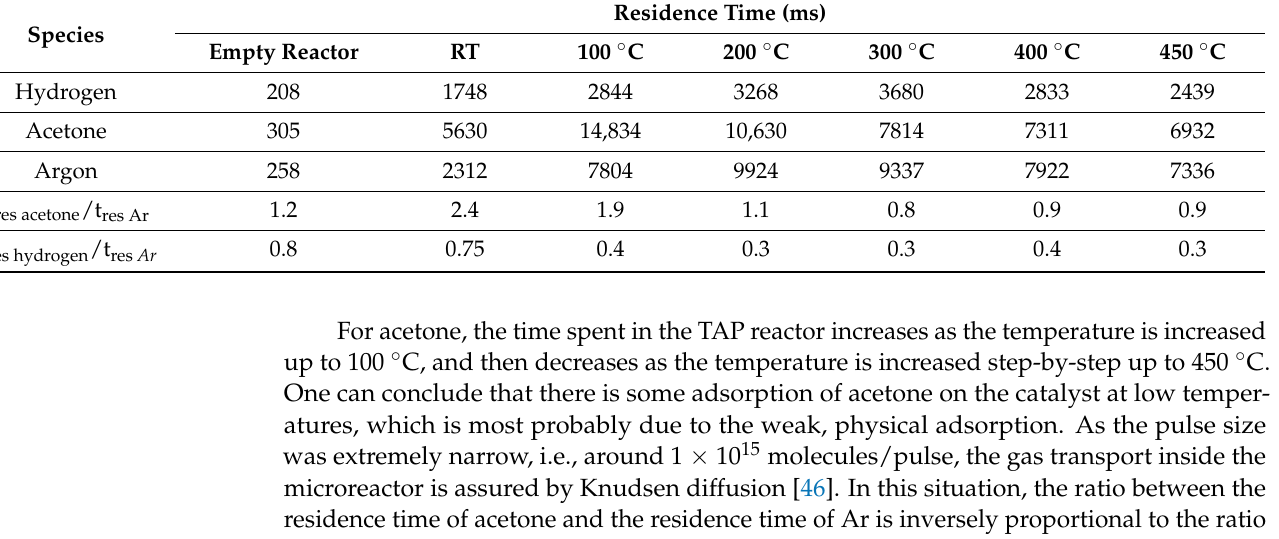
Table 4. Calculated residence time for H 2 , acetone, and Ar responses in an empty TAP reactor along with their responses over the catalyst at RT, 100, 200, 300, 400, and 450 °C.